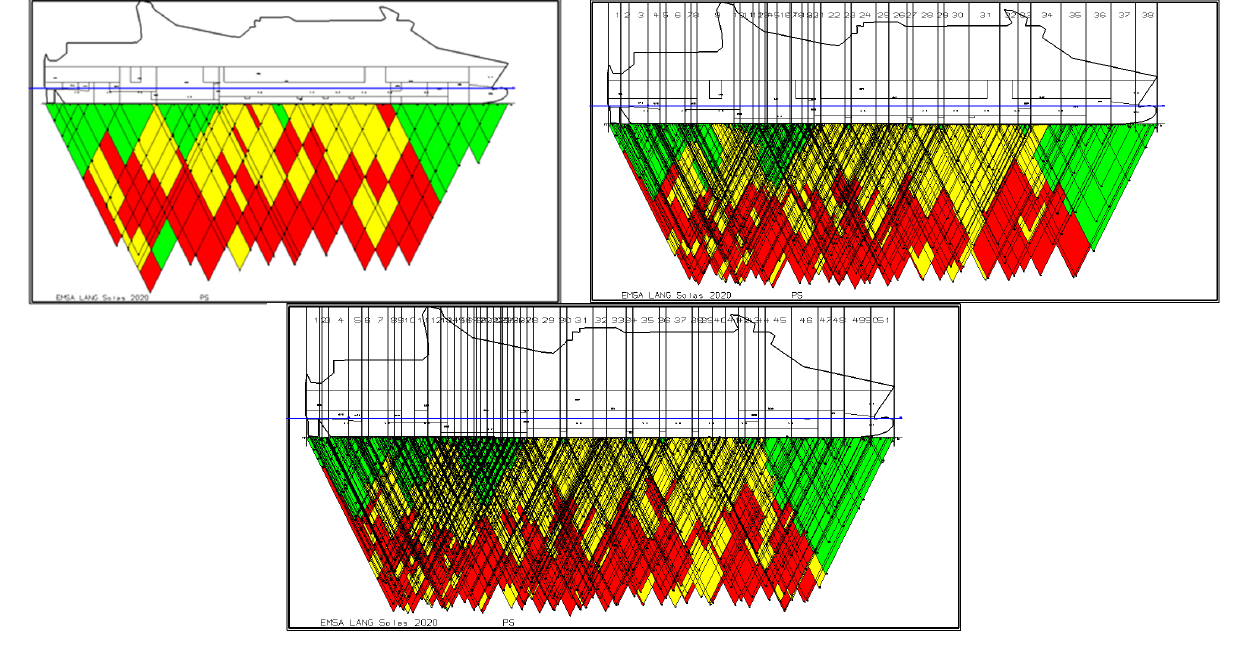
Figure 7. Damage stability output with three different damage zone realizations.